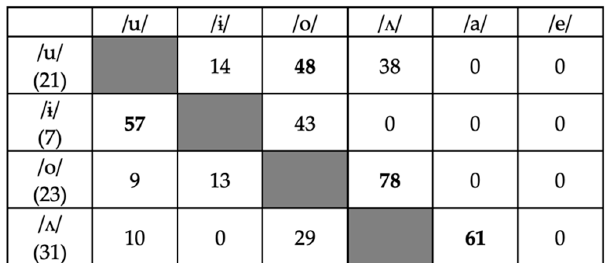
Figure A5. Confusion matrix of errors by the some ‐ contrast group in the posttest for vowel items (vertical = stimuli, horizontal = responses). Each cell shows the percent of all errors on the given stimulus represented by the given response (rows may not add to 100% due to rounding); the most common error type for each stimulus is bolded. The total number of errors for each stimulus (across all participants in the group) is shown in parentheses.